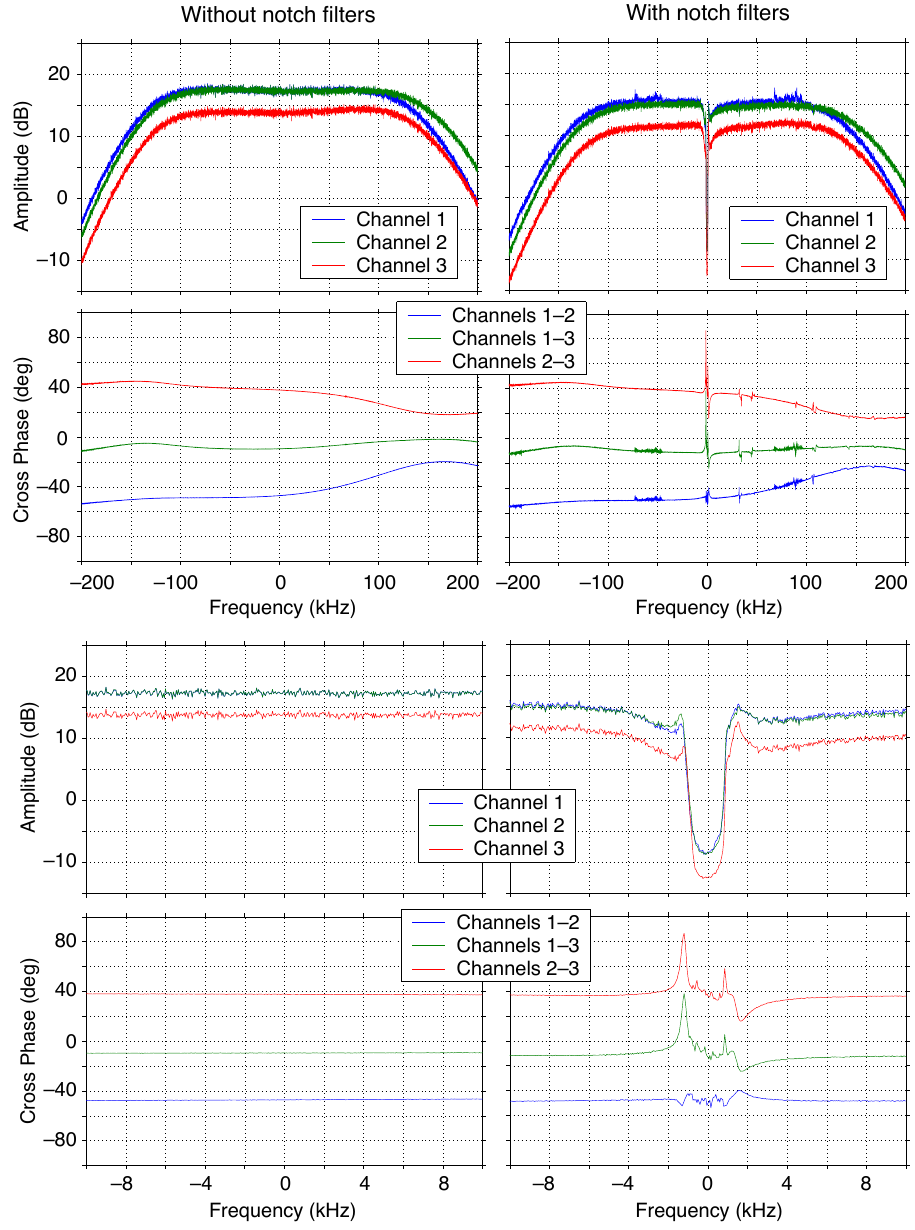
Fig. 11. The magnitude and cross-phase responses of the three digital receiver channels used to record the interferometric data channels, with and without the 5.423-MHz notch filters. For these measurements a white noise source was divided into the three receiver channels and data was recorded simultaneously in all three. Because of this, the fluctuations in the different channels are nearly identical, and the blue trace (channel 1) is, for example, nearly perfectly hidden behind the green trace (channel 2) in the lower left panel. The red trace (channel 3) is about 3.5dB below the other two due to differences in the signal paths. The filters have 3-dB points at about ± 1kHz from the center frequency. The frequency resolution in these plots is 50Hz. Note that the filters were not used in recording the data presented in this report. discussed above, 50-m baselines provide a geometrical fringe spacing of about 50 ◦ at 8 MHz and about 100 ◦ at 4